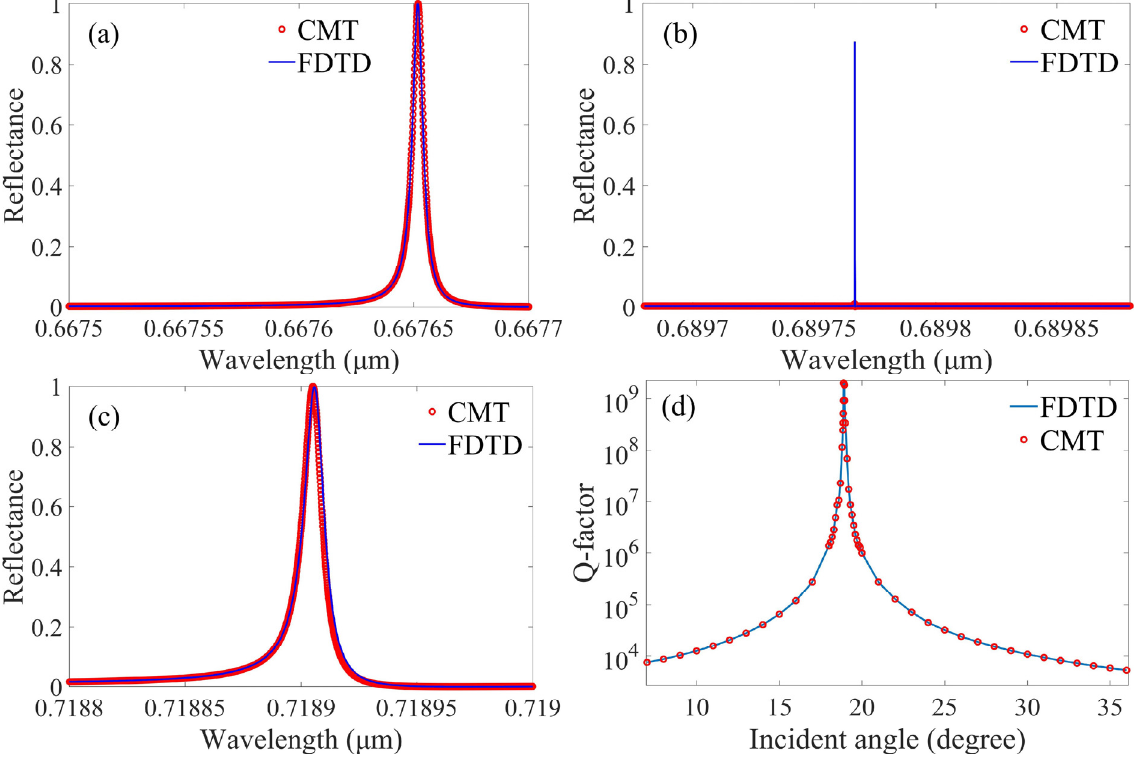
Figure 4. The reflectance spectra of the metasurface extracted from Figure 2 simulated from FDTD (solid lines) and temporal CMT (circle dots) at the incidence angle ( a ) for the BIC at 16°, 0.6676519 µm, ( b ) for the BIC at 19° about 0.6897667 µm, and ( c ) for the BIC at 23°, about 0.7189055 µm. ( d ) Q-factor of the reflectance resonance modes including BIC from FDTD (solid lines) and CMT calculation (circle dots) as a function of incident angle of the H − shaped nanohole metasurface.